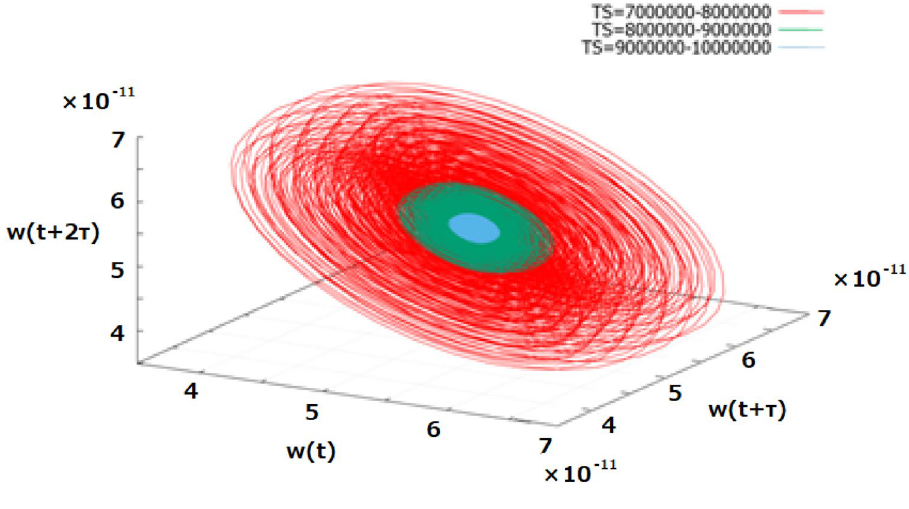
Fig. 9 Attractor of 2-vortex mode at Γ = 2.1, Re = 1680 (TS = 7 million to 10 million). The numerical dimensionless values 6 on the axes indicate 2.1506 × 10